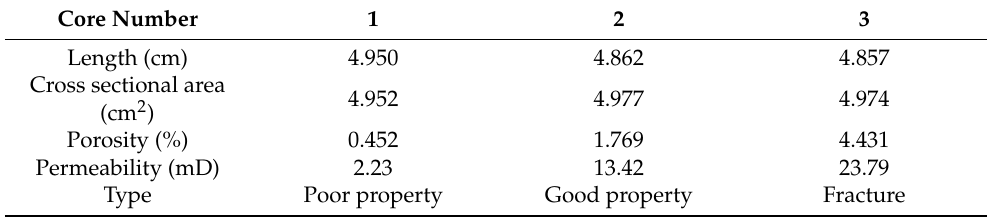
Table 3. Core basic